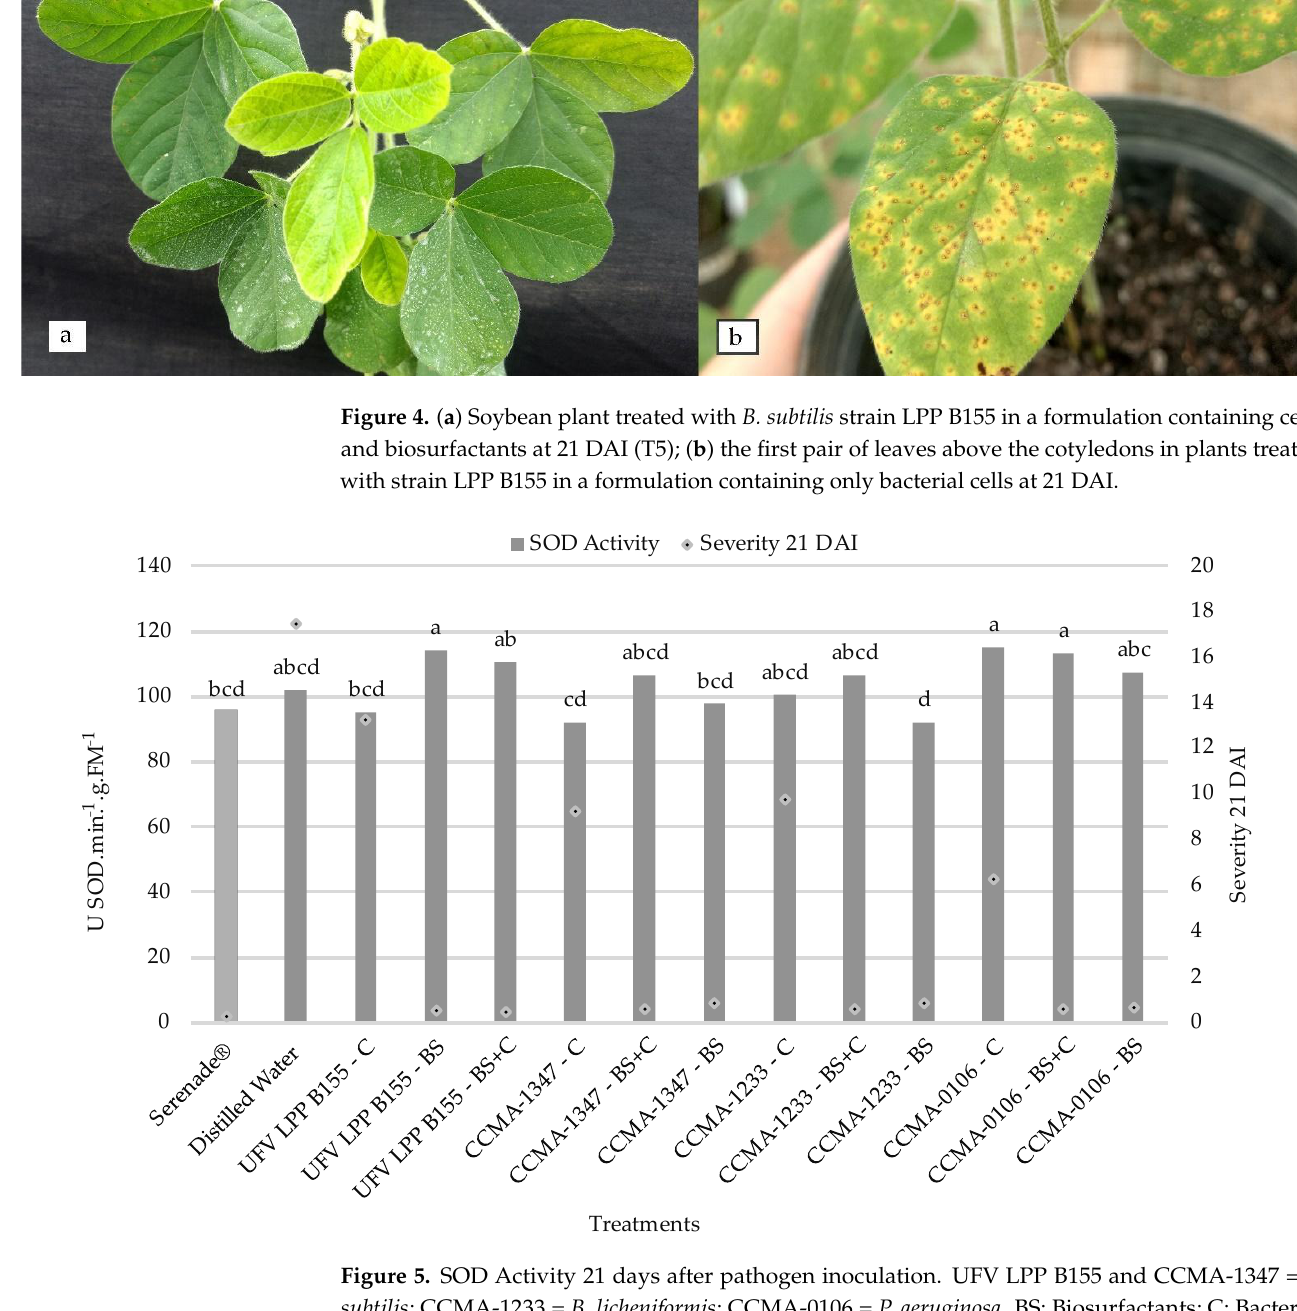
Figure 5. SOD Activity 21 days after pathogen inoculation. UFV LPP B155 and CCMA-1347 = B. subtilis ; CCMA-1233 = B. licheniformis ; CCMA-0106 = P. aeruginosa . BS: Biosurfactants; C: Bacterial cells; BS + C: Biosurfactants + Bacterial cells. Bars followed by the same letter do not differ from each other by Tukey’s test α = 0.05. The primary Y-axis shows activity in U SOD · min − 1 · g · FM − 1 , and the secondary Y-axis shows severity, represented by the dark-colored dot. Different letters reveal statistically significant variations ( p <